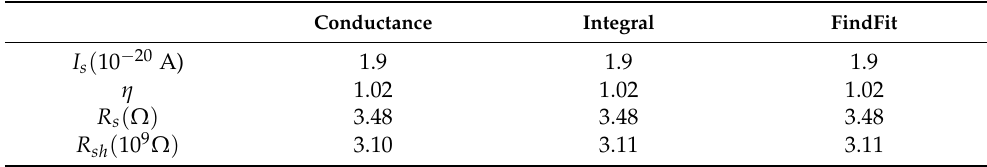
Table 1. Iridium-silicon carbide Schottky diode physical parameters values obtained via three different methods using the experimental I–V characteristics.